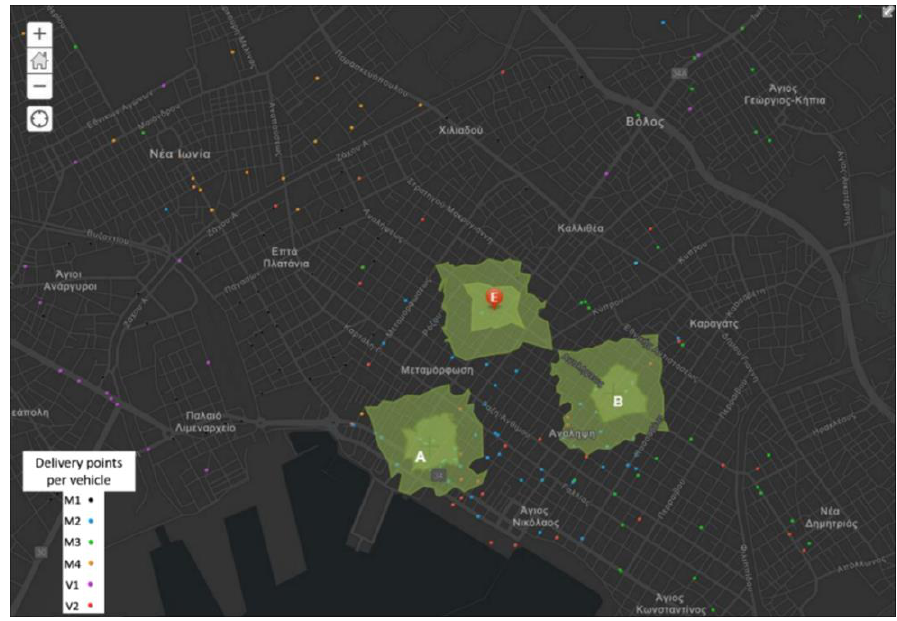
Figure 2. Isochrones map showing 1.5- and 3-min walking distances from (A), (B) and (E).